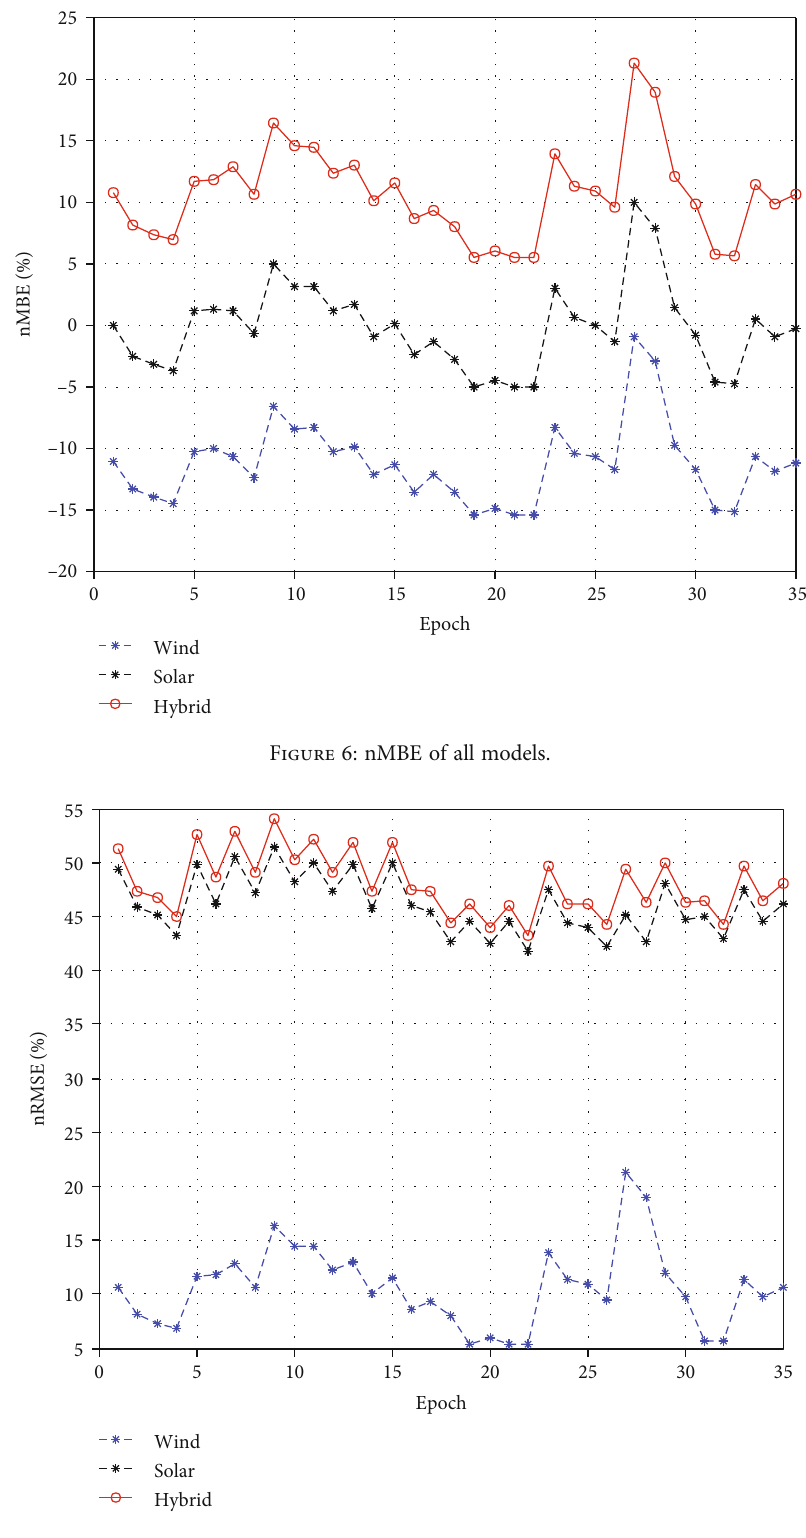
Figure 7: nRMSE of all